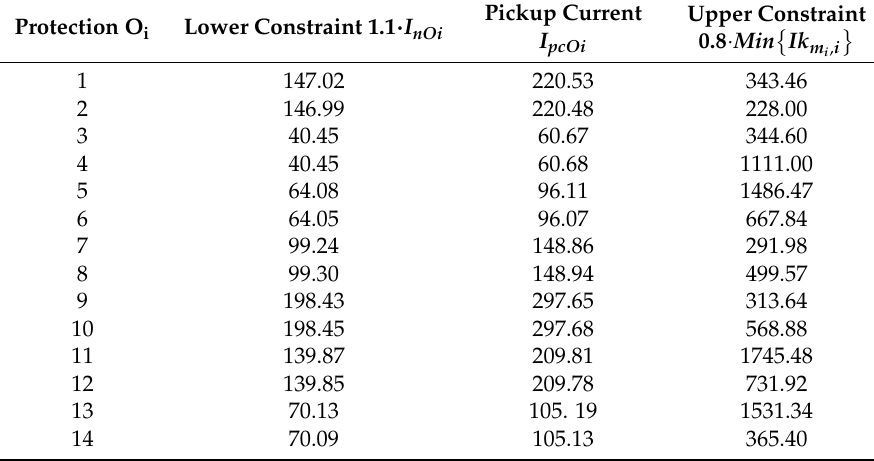
Table 5. IEEE 6-bus power system pickup currents and constraints (all values in